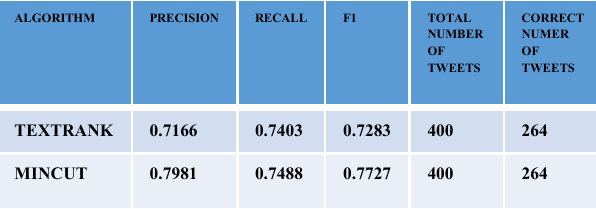
Table 4. Represent the comparison between min-cut and text rank. It says that min-cut is better than the text rank algorithm. The correct number of tweets that match the total number of tweets in the min-cut algorithm is more than the algorithm.